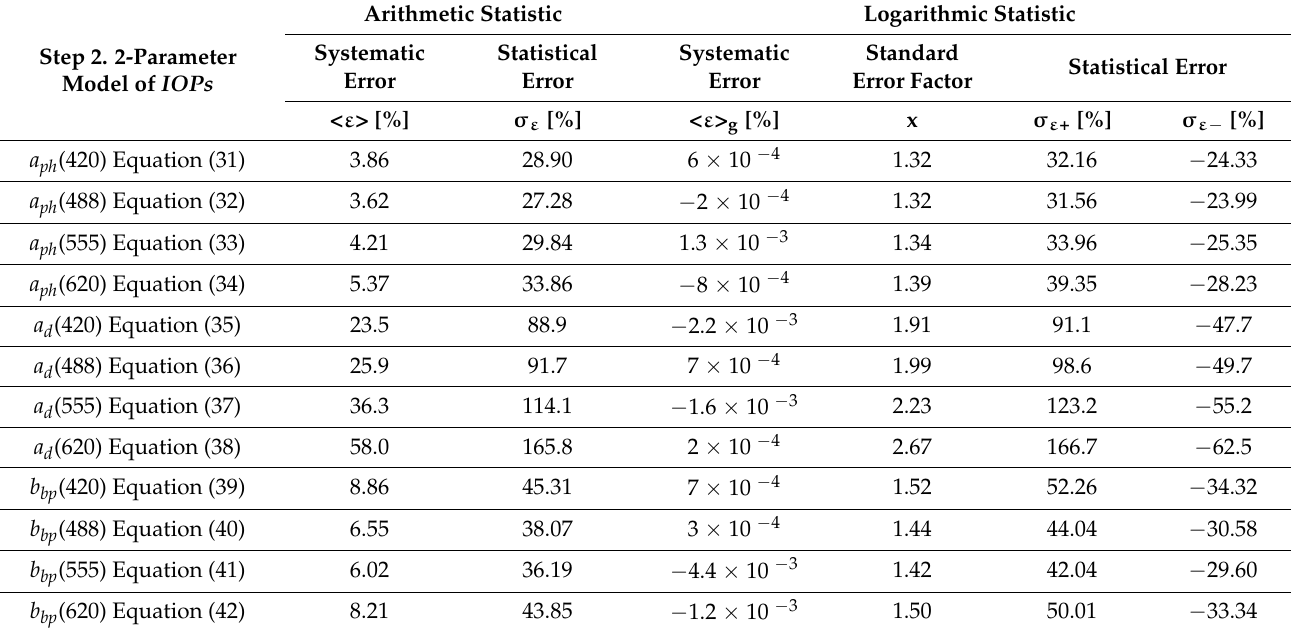
Table 2. The relative errors in the